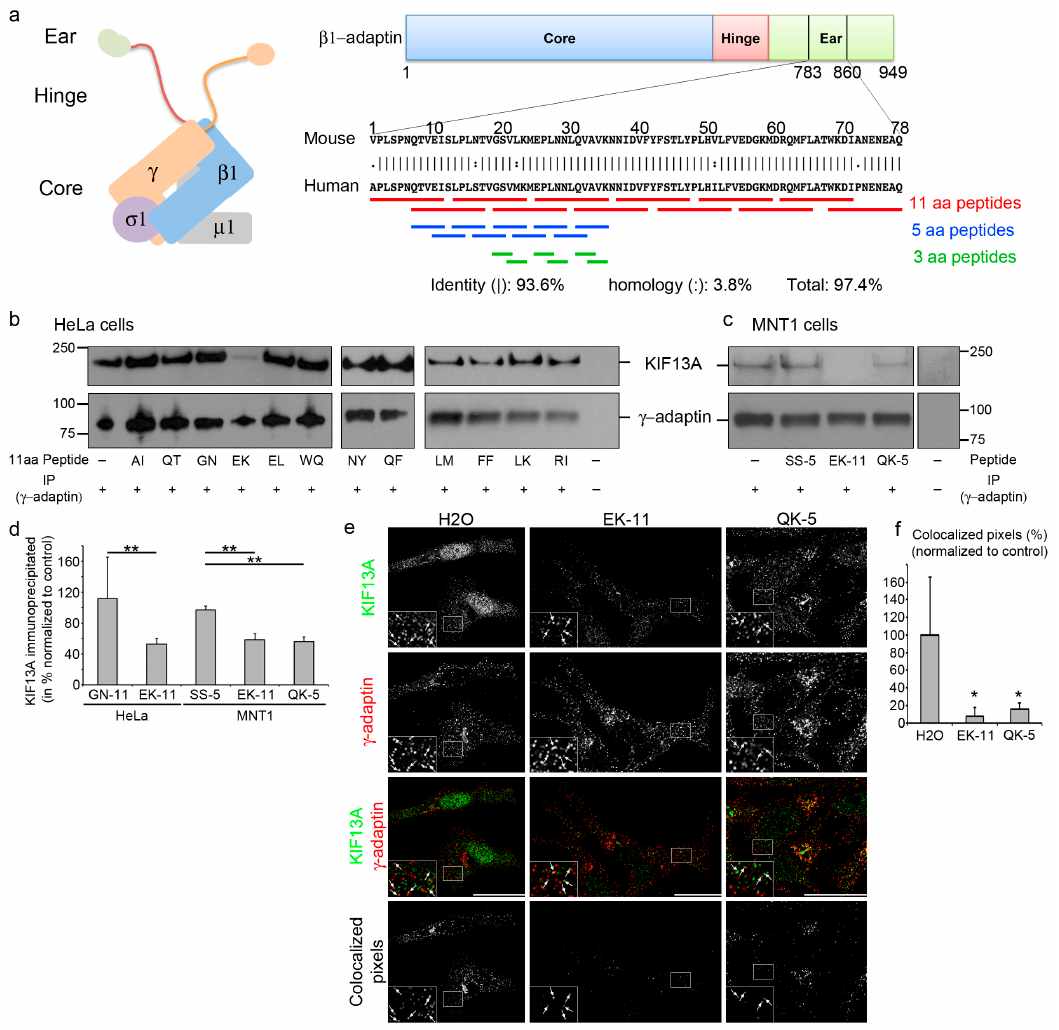
Table 1) might overlap the KIF13A binding site and, thus, represent a blocking peptide. Importantly and similarly to EK-11, the incubation of MNT-1 cell lysates with QK-5 decreased the level of precipitated 5 decreased the level of precipitated KIF13A (Figure 1c,d) relative to a 5aa SS-5 peptide—found as a KIF13A (Figure 1c,d) relative to a 5aa SS-5 peptide—found as a non-blocking peptide with comparable non-blocking peptide with comparable physicochemical properties and, therefore, used as a control physicochemical properties and, therefore, used as a control peptide (Table 1). Therefore, these results peptide (Table 1). Therefore, these results indicate that both EK-11 and QK-5 most likely target the indicate that both EK-11 and QK-5 most likely target the same KIF13A binding site; with the QVAVK same KIF13A binding site; with the QVAVK sequence of the human β 1-adaptin (Table 1) sequence of the human β 1-adaptin (Table 1) corresponding to a putative interaction motif. corresponding to a putative interaction motif.